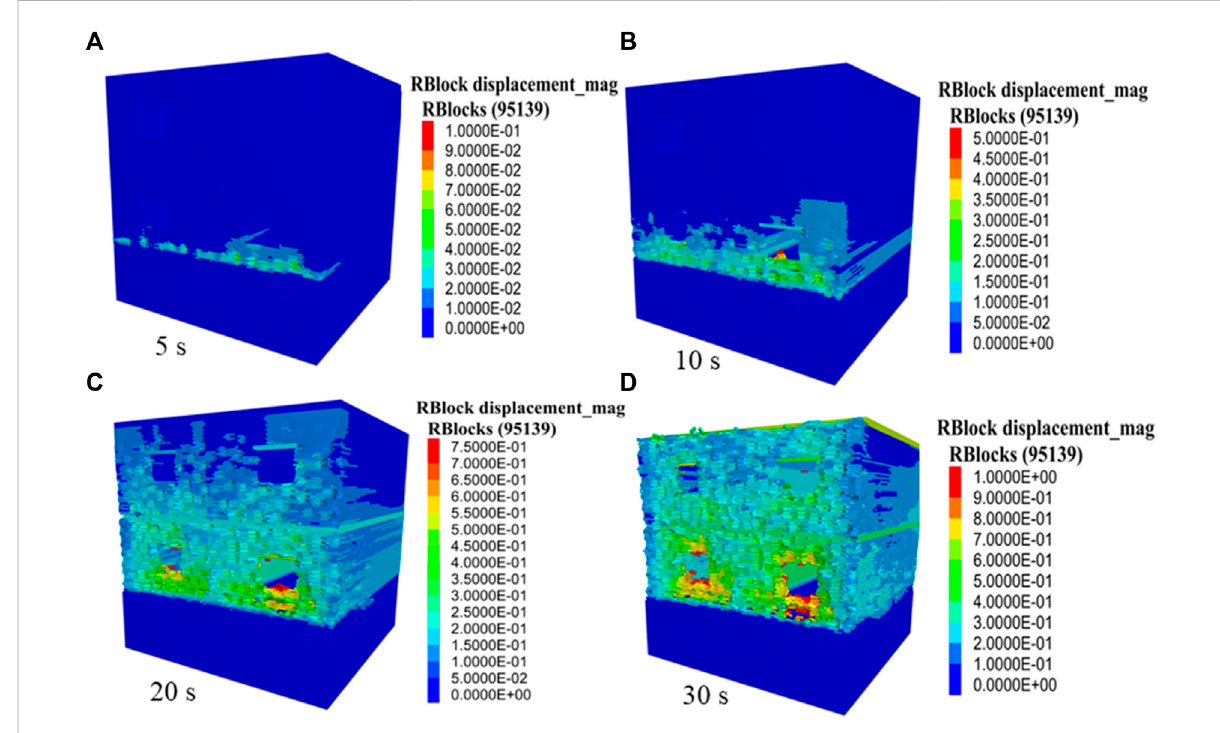
FIGURE 12 Cloud image of displacement of building walls at different